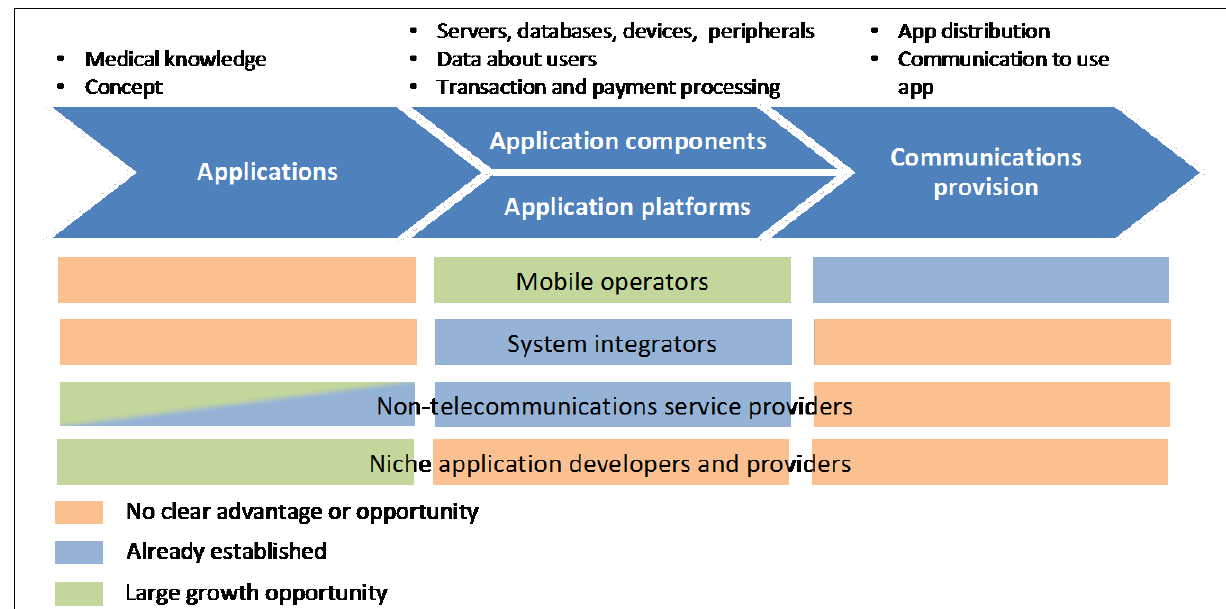
Figure 20 : Potential for value capture by main actors in